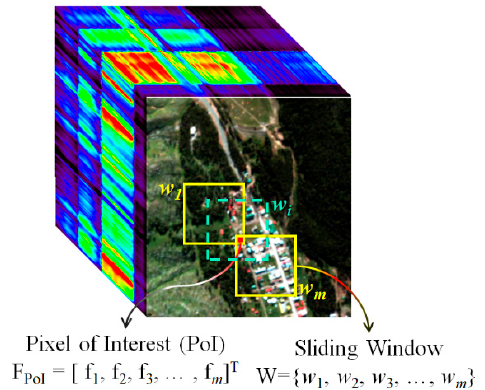
Figure 1. Structure of moving the sliding window around the PoI .